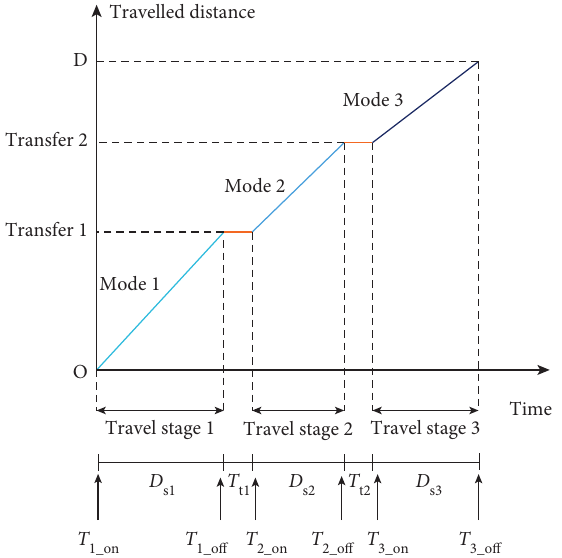
Figure 2: Two-dimensional structure of an individual PT travel